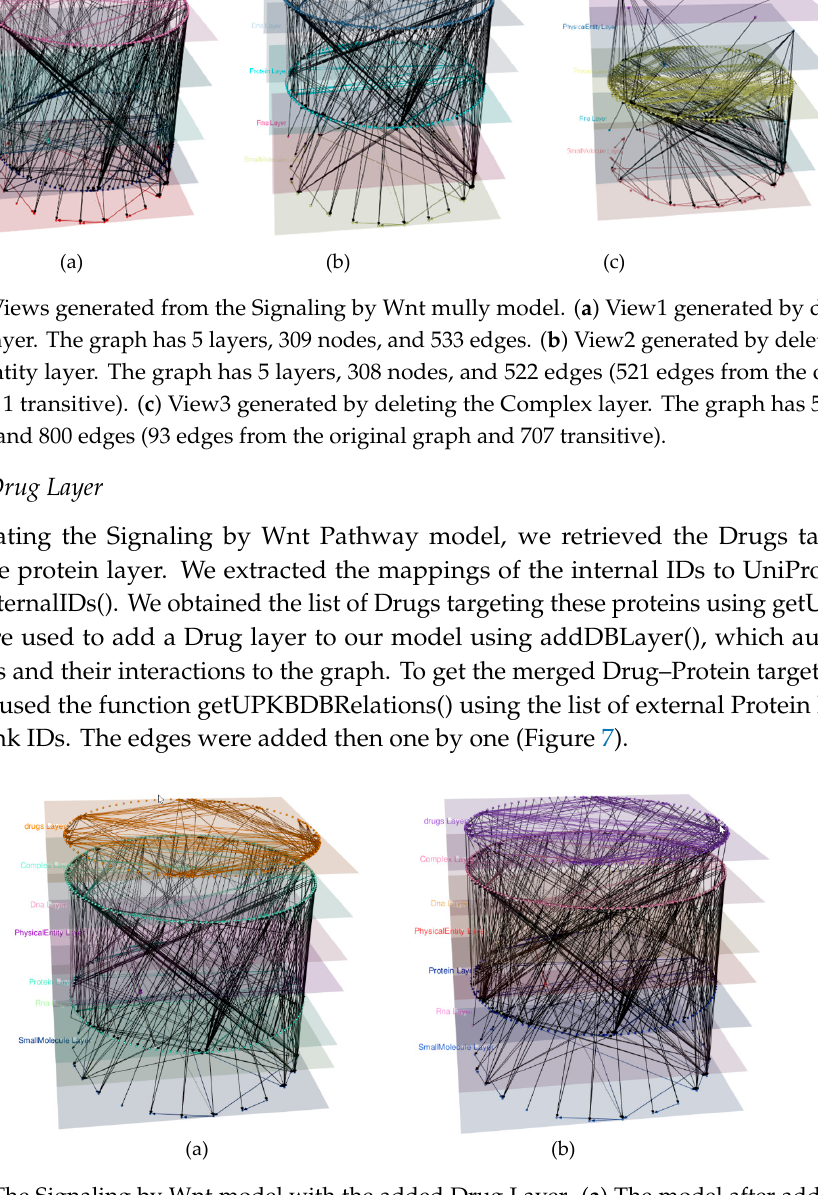
Figure 7. The Signaling by Wnt model with the added Drug Layer. ( a ) The model after adding the Drug layer. The layer contains 83 drugs and 260 Drug Interactions. ( b ) The model after adding the connections between the drugs and proteins’ nodes, merged from DrugBank and UniProt. The Drug targets obtained are 97, many of them added as multi-edges, since a single internal protein ID was mapped to multiple UniProt